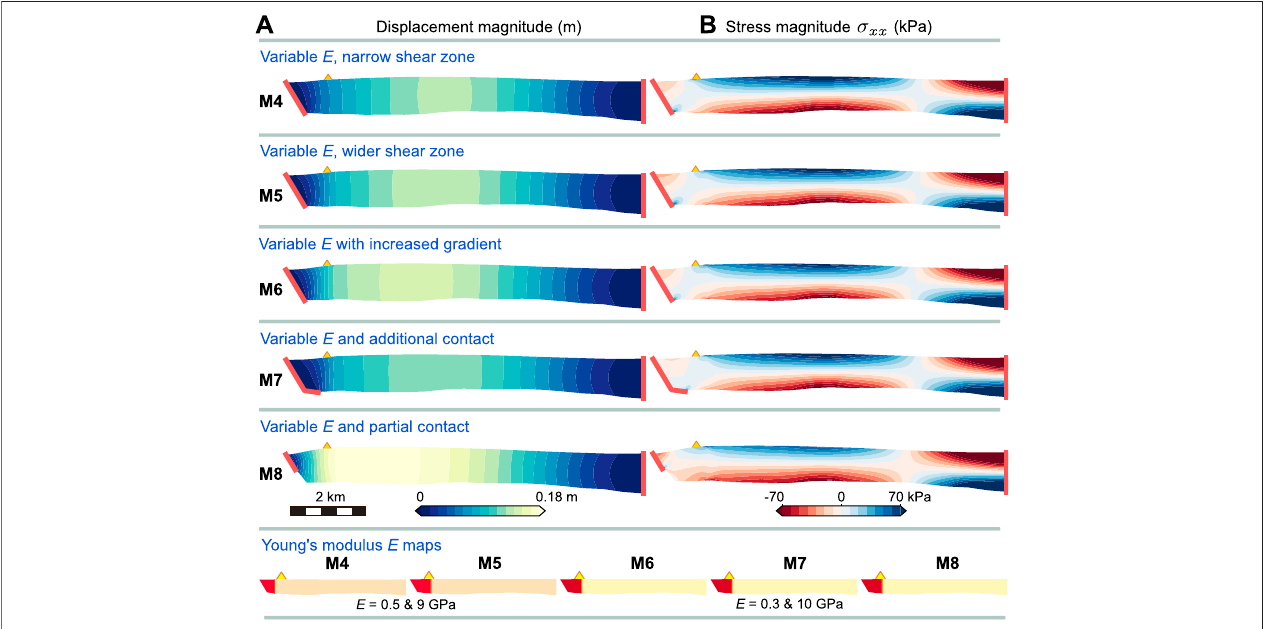
FIGURE 10 | Upward de fl ection of the ice layer for fi ve experiments with spatially variable E across the shear margin. The fi rst column shows the displacement magnitude and the second column is the transverse (across- fl ow) component of the stress tensor. Negative stresses are compressive and positive stresses are tensile. Opposite downward bending of the ice layer is shown in Supplementary Section 3.4 .